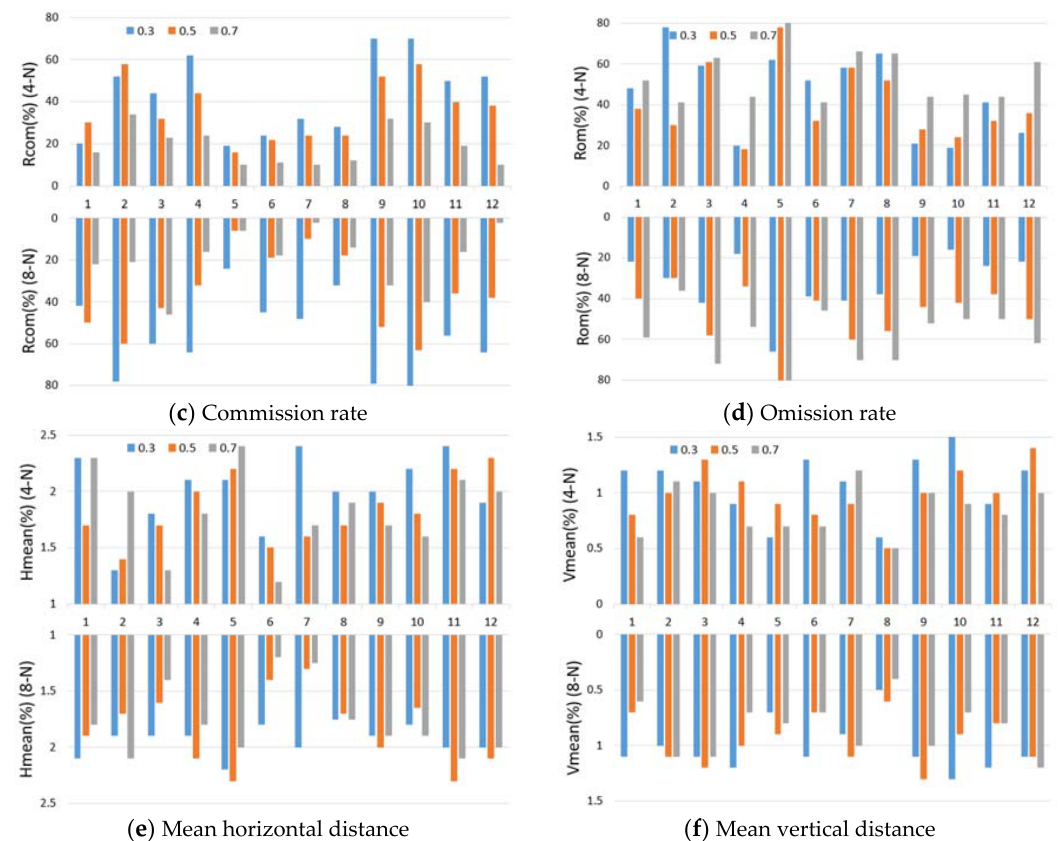
Figure 10. The evaluation parameters for each plot of the study plots (the raster resolutions are 0.3, 0.5, and 0.7 m respectively, and the numbers indicate the plot IDs).